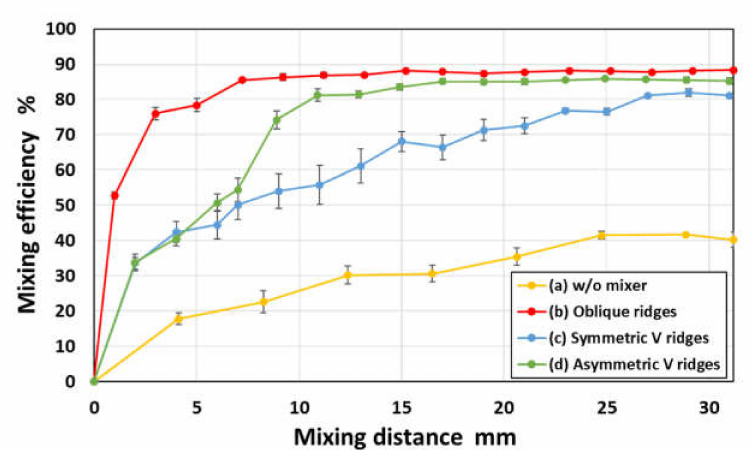
Figure 9. Experimental results showing the mixing e ffi ciency of three di ff erent types of chaotic mixers with periodic oblique, symmetric V-shaped, and asymmetric V-shaped ridges as a function of the mixing distance along the flow direction. For comparison, the data obtained in a rectangular microchannel without ridges is also plotted in the graph. Note that each point and error bar in the plot represent the mean values and their standard deviations,